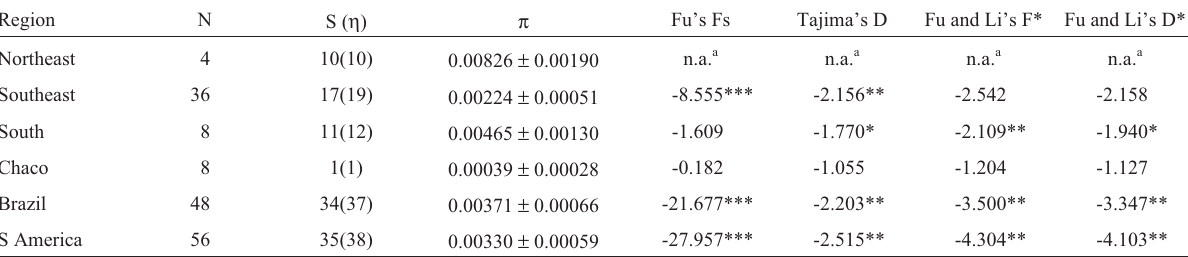
Table II - Neutrality tests and mismatch distribution analyses. Region